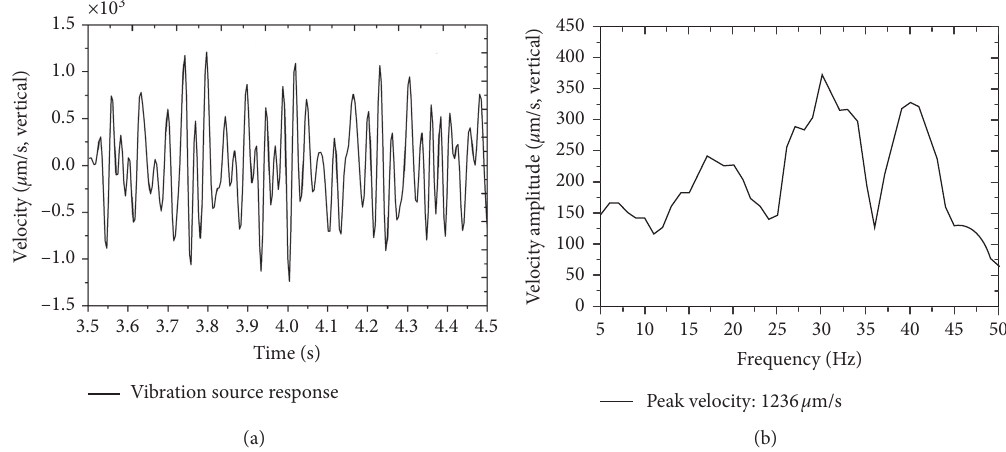
Figure 11: Vibration source response used in the antivibration foundation design: (a) velocity time history, (b) velocity spectrum.